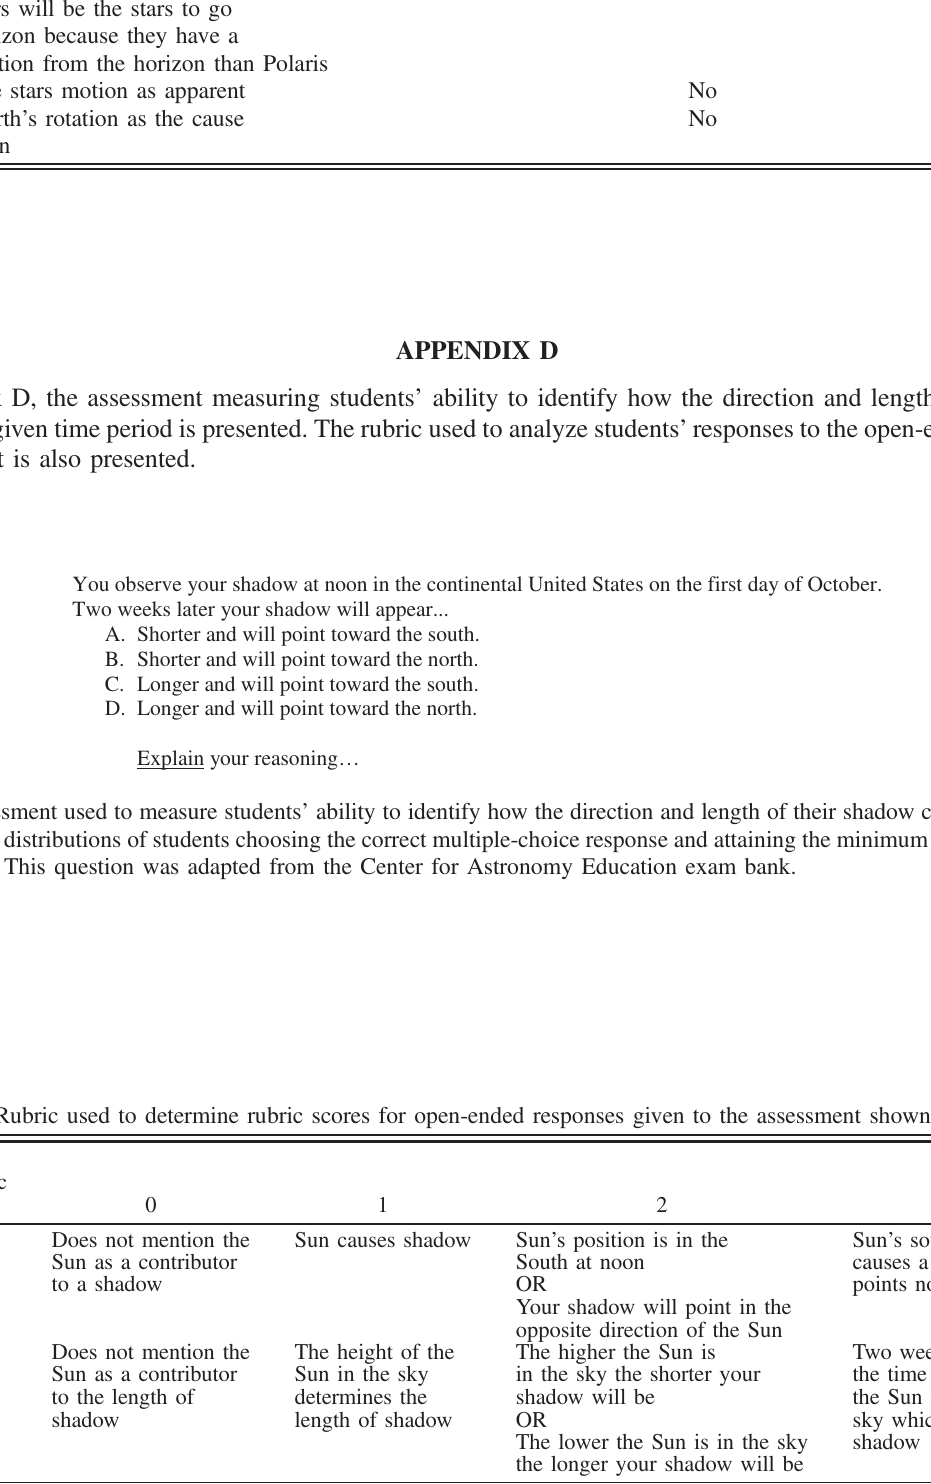
TABLE XIII. Rubric used to determine rubric scores for open-ended responses given to the assessment shown in Fig.